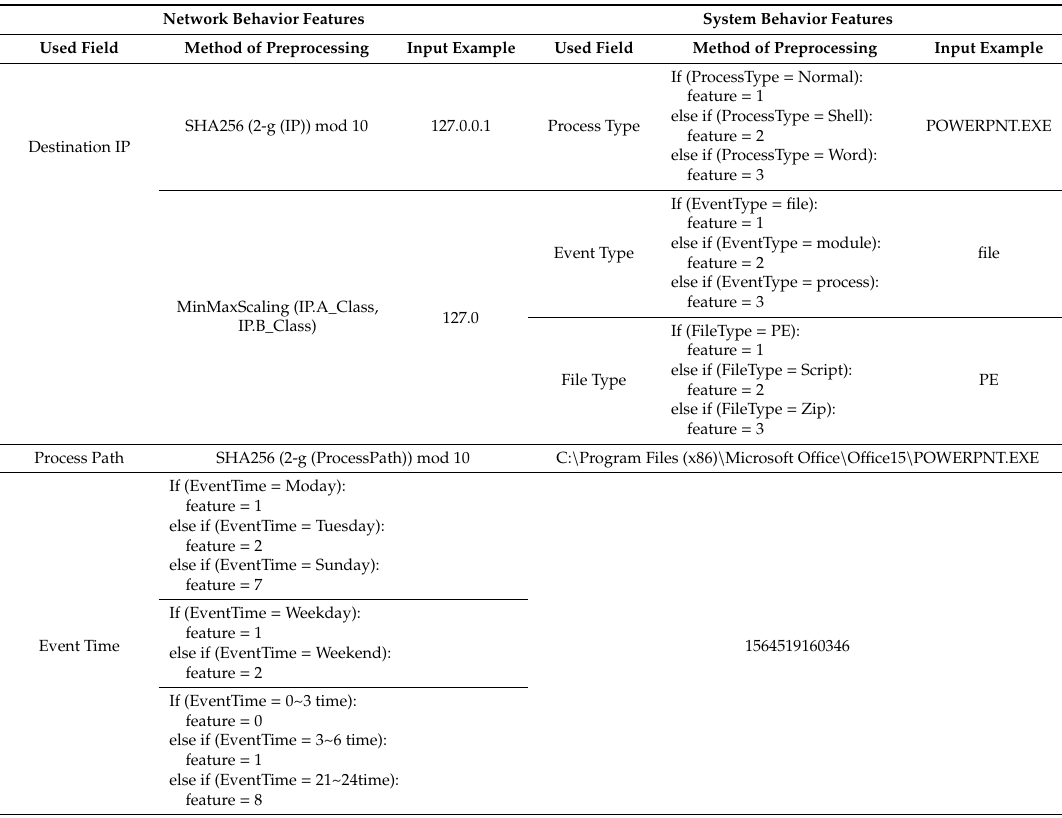
Table 4. Example feature preprocessing of AutoEncoder